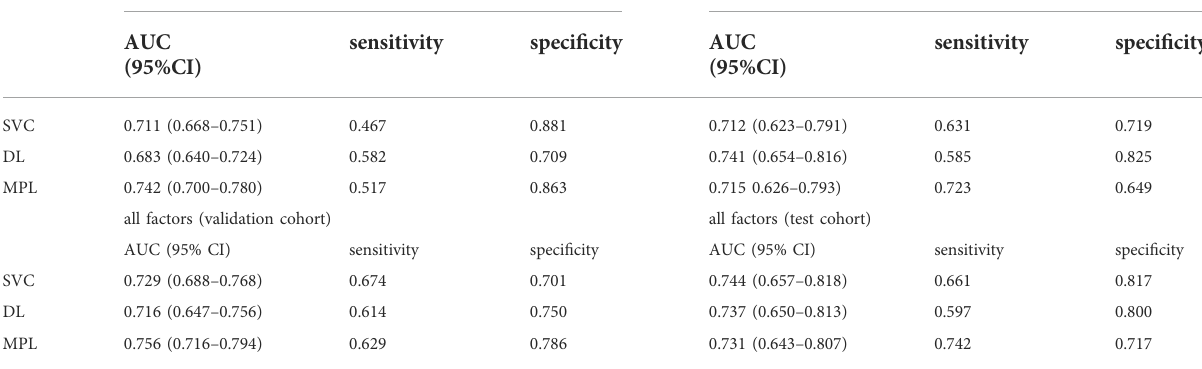
TABLE 3 Predictive power of machine learning models for NSAIDs ef fi cacy.